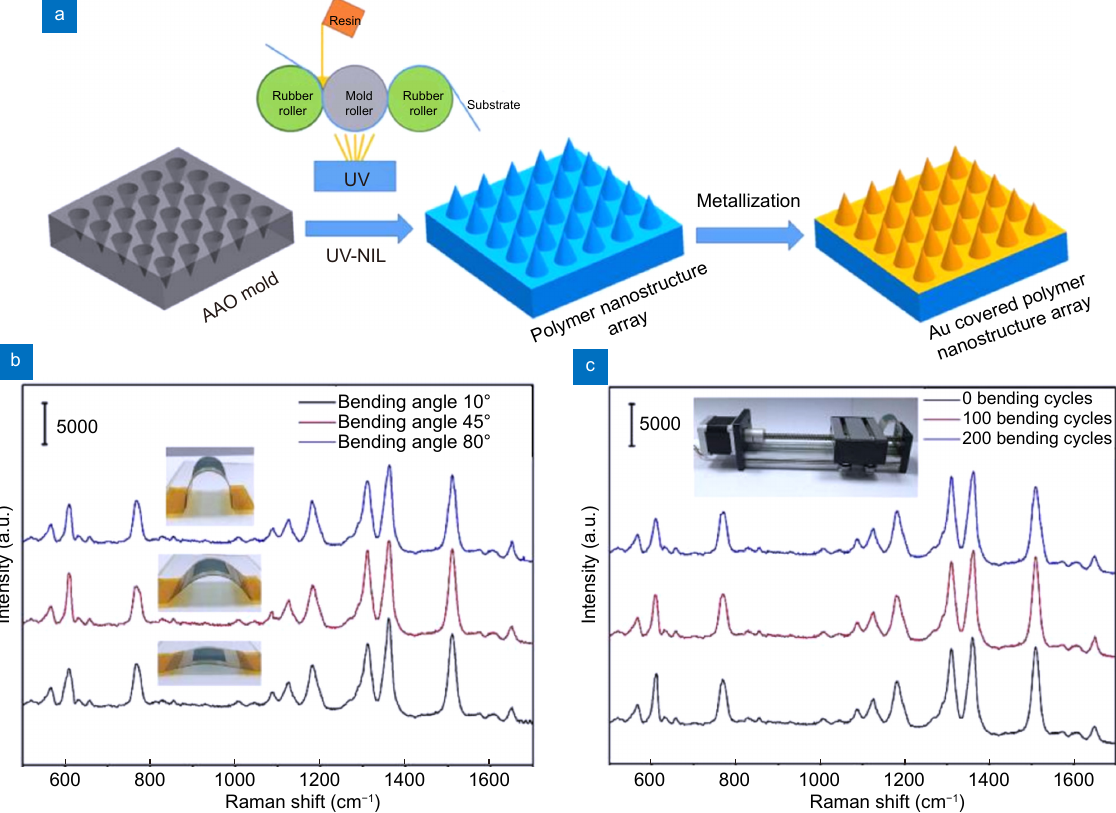
Fig. 10 | ( a ) Schematic diagram representing the fabrication process of Au covered polymer nanostructure arrays using roll-to-roll ultraviolet nanoimprint lithography (R2R UV-NIL) technique ( b ) and ( c ) SERS spectra of R6G from 30 nm Au coating flexible substrate at different bending angles and bending cycles, respectively. Figure reproduced with permission from ref. 114 , under a Creative Commons Attribution 4.0